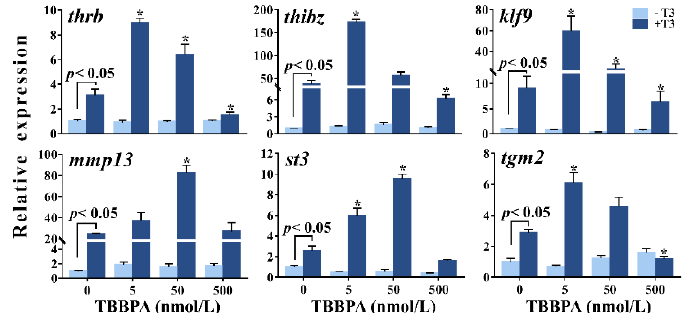
Figure 1. The relative expression of six thyroid hormone-response genes in brains of premetamorphic Xenopus laevis tadpoles following two-day exposure to tetrabromobisphenol A (TBBPA) in the absence or presence of 1 nmol/L T3. Data are shown as mean ± SEM. * indicates significant differences between TBBPA + T3 treatment and T3 treatment ( p < 0.05).